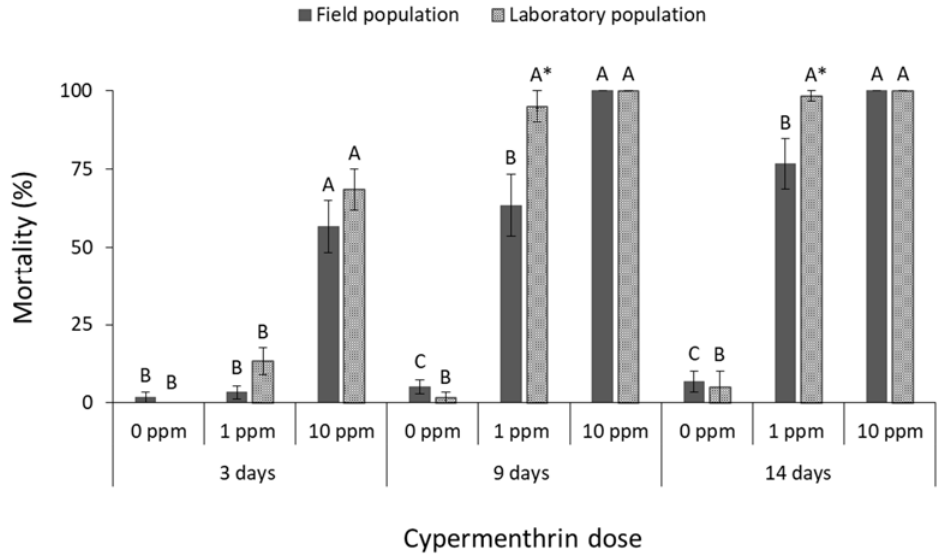
Figure 2. Mean (% ±SE) adult mortality of field and laboratory populations of R. dominica after 3, 9 and 14 days of exposure to different concentrations of cypermethrin (within each exposure interval and population, means followed by the same letter are not significantly different; where no letters are present, no significant differences were noted; HSD test a 0.05; within each exposure interval and dose, means with asterisk (*) indicate significant differences between the populations, according to Students’ t –test at p < 0.05).